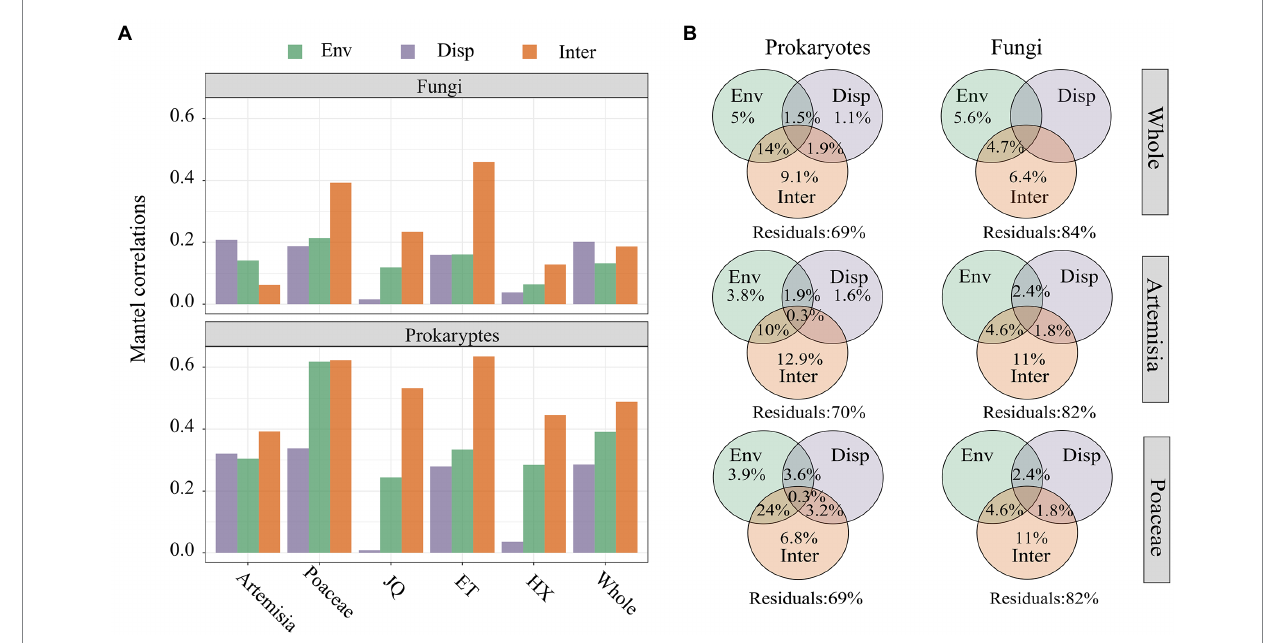
TABLE 2 Partial mantel test results showing comparisons between microbial community dissimilarity, β NTI, and a one-distance matrix while controlling for the other two distance matrices. Organism Test Parameter Inter ( Controlling Env ( Controlling Disp ( Controlling for Env and Disp ) for Inter and Disp ) for Env and Inter ) Prokaryotes β NTI r 0.40 0.24 0.038 <0.001 <0.001 Bray <0.001 <0.001 <0.001 Fungi <0.001 Bray <0.001 <0.001 <0.001 Inter, Env and Disp indicate the distance matrix of network attributes, environmental variables and geographic locations,